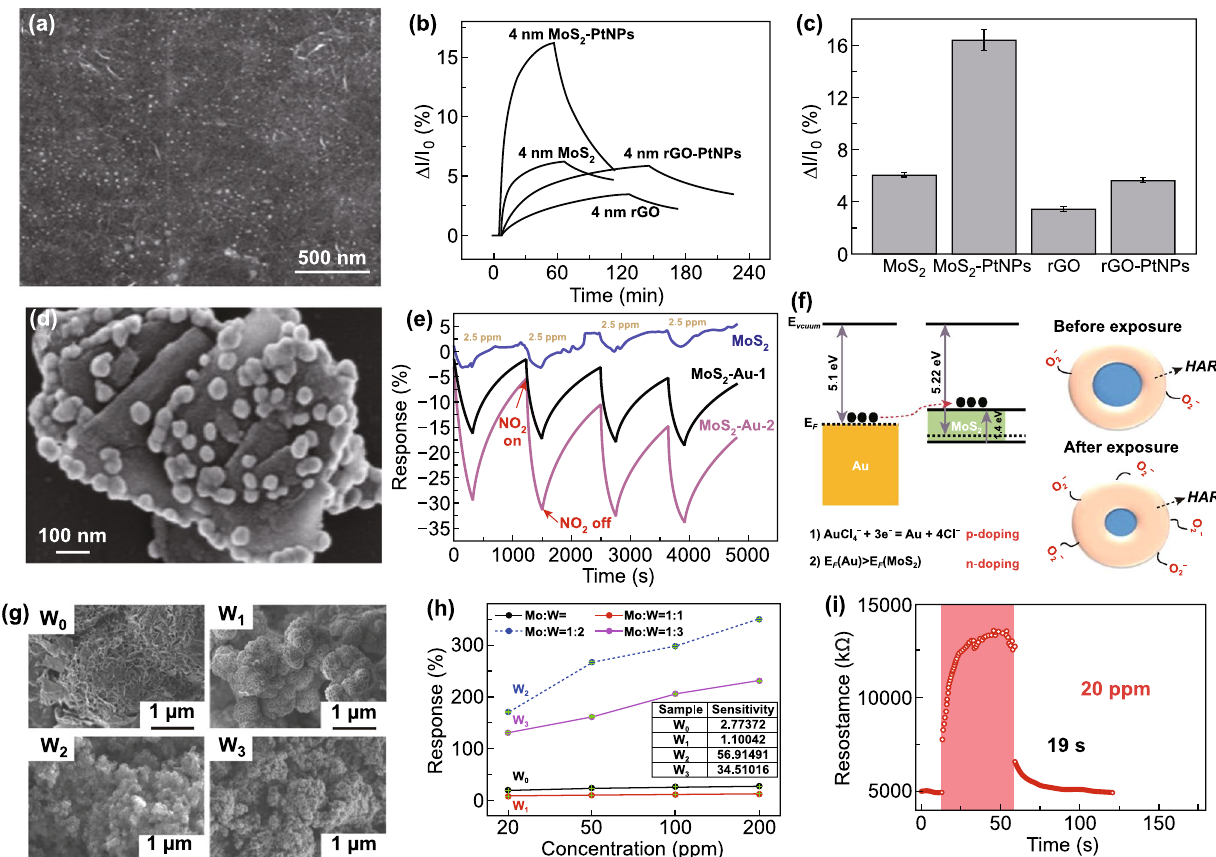
Fig. 14 a Pt-doped 4-nm-thick MoS 2 . b Response of the Pt NP-doped MoS 2 , MoS 2 -rGo and of bare rGO. Pt NP-doped MoS 2 showed the high- est response for the NO 2 adsorption. c Selectivity profile. Reproduced with permission from Ref. [42]. Copyright (2012) Wiley-VCH. d Au NP-doped MoS 2 . e Response profile with different concentrations of Au decorated MoS 2 and with UV light exposure. f Band alignment of MoS 2 and Au NPs and mechanism of NO 2 adsorption. Reproduced with permission from Ref. [121]. Copyright (2018) AIP Publishing. g Different concentration W metal loaded MoS 2 . h Sensor response profiles of W loaded MoS 2 . i Response and recovery profile for 20 ppm NO 2 exposure. Reproduced with permission from Ref. [320]. Copyright (2020)